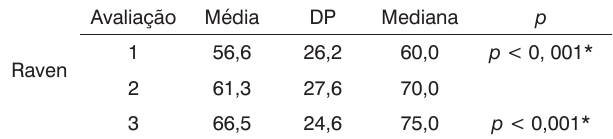
Tabela 2. Resultado dos Percentis do Teste das Matrizes Progressivas Coloridas de Raven - Escala Especial nas três avaliações.